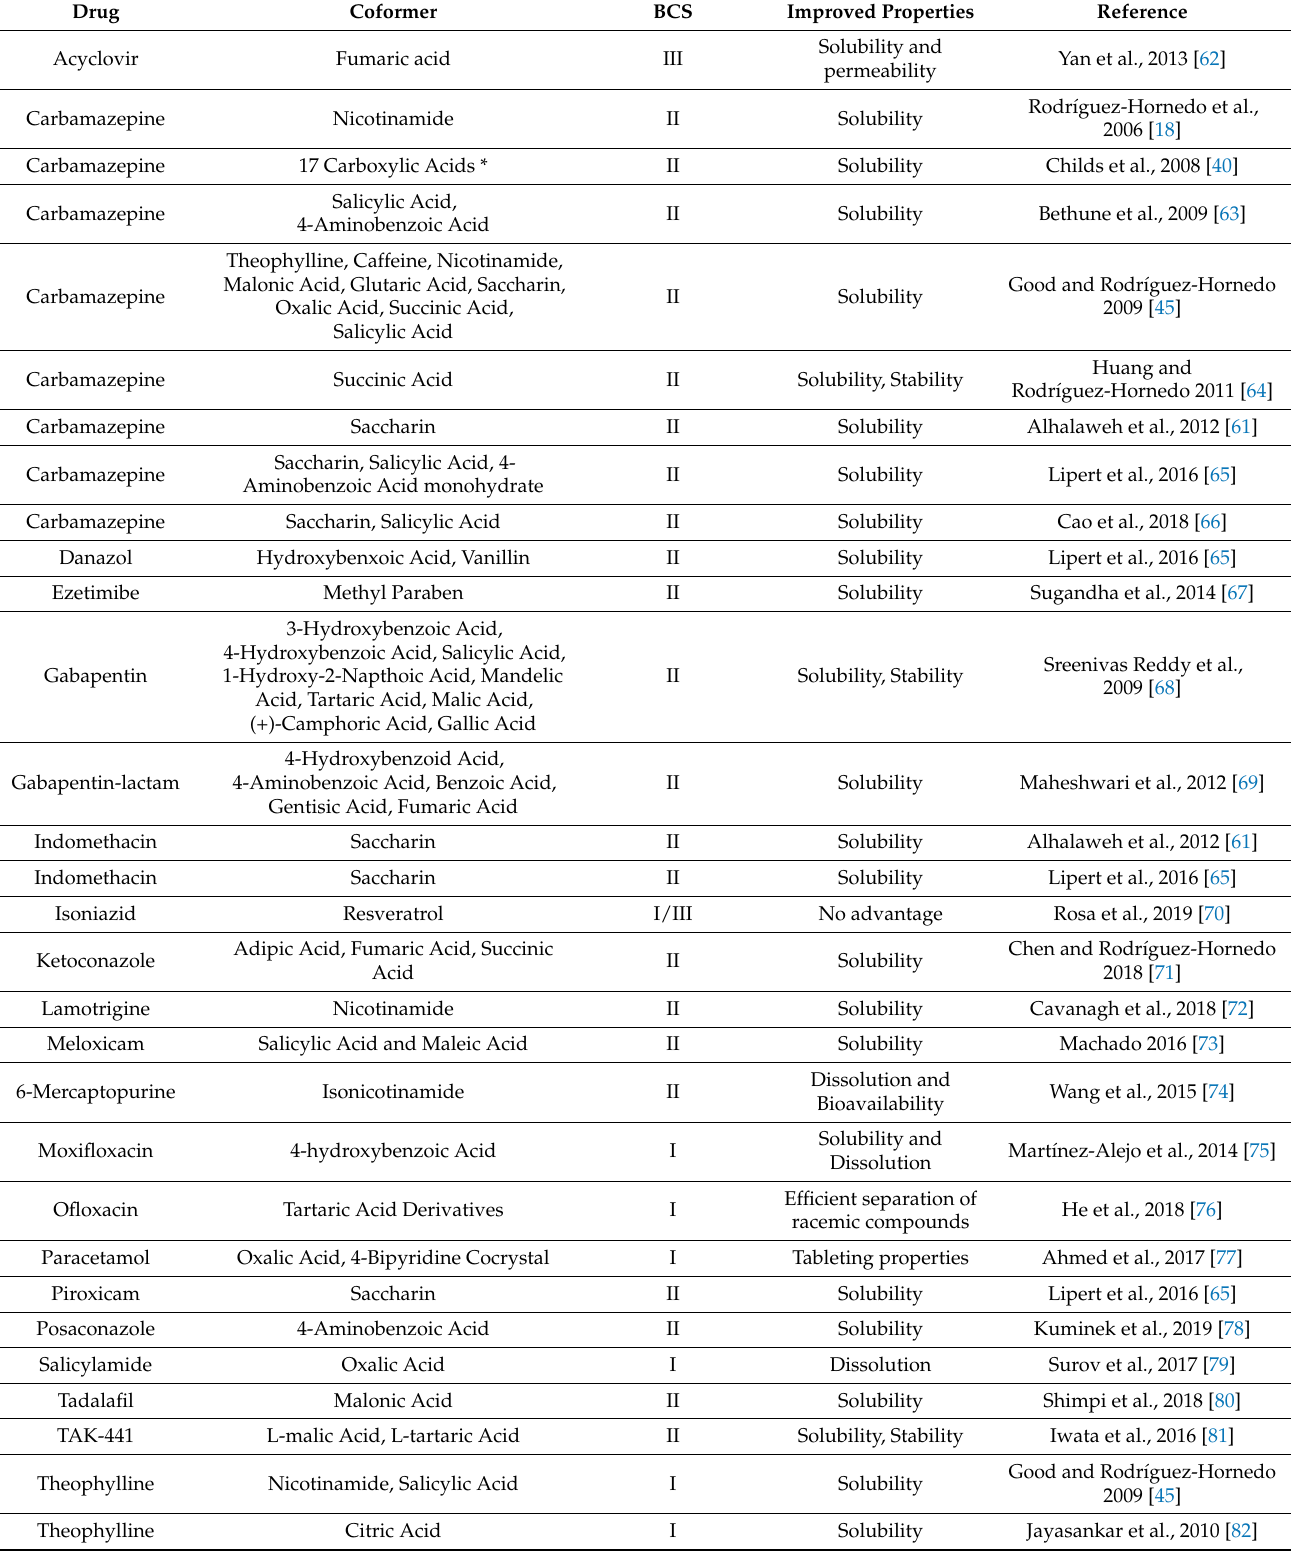
Table 1. Examples of cocrystals obtained by the